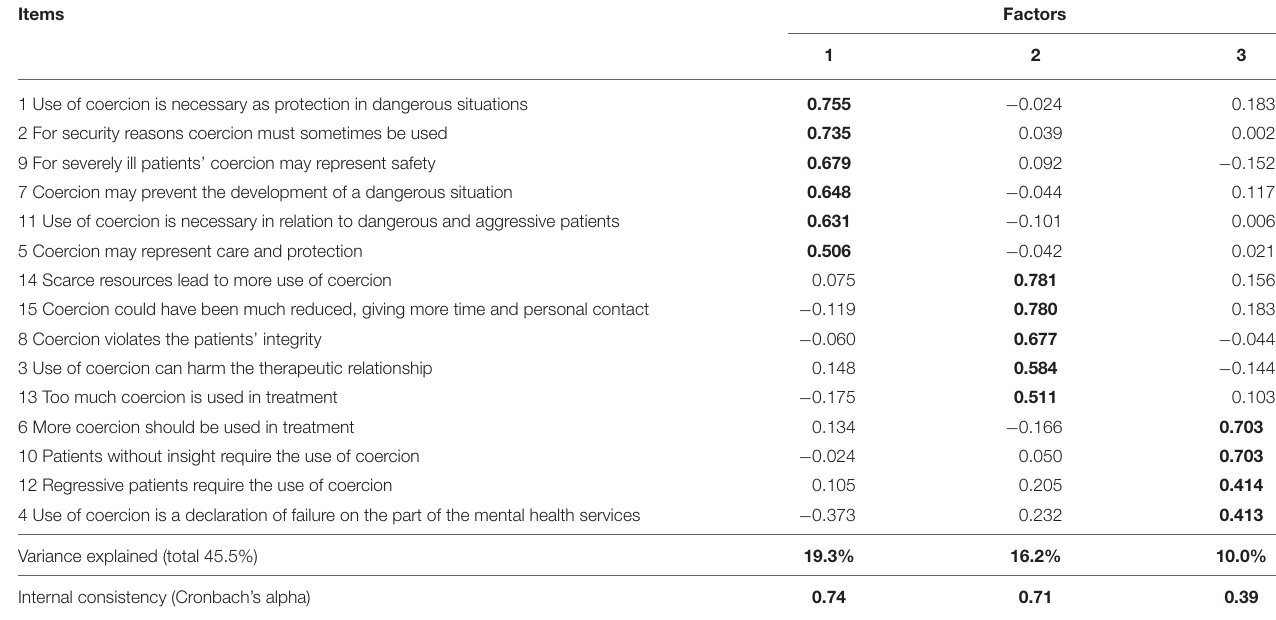
TABLE 2 | Confirmatory factor analysis of three factors of staff attitudes to coercion scale: Principal components analysis with varimax rotation.